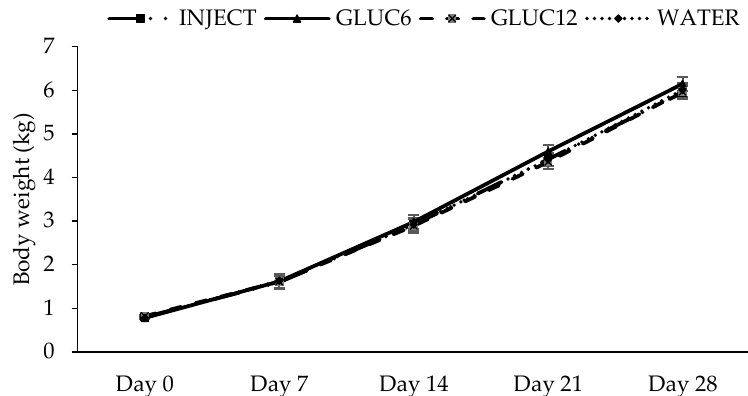
Figure 1. The body weight during lactation (until day 28) for the four treatments;WATER: 2 × 6 mL oral water (control) ( n = 29)), INJECT: 2 × 6 mL glucose injected ( n = 33), GLUC6: 2 × 6 mL oral glucose ( n = 31), and GLUC12: 2 × 12 mL oral glucose ( n = 31). Results are presented as lsmeans ± SEM.